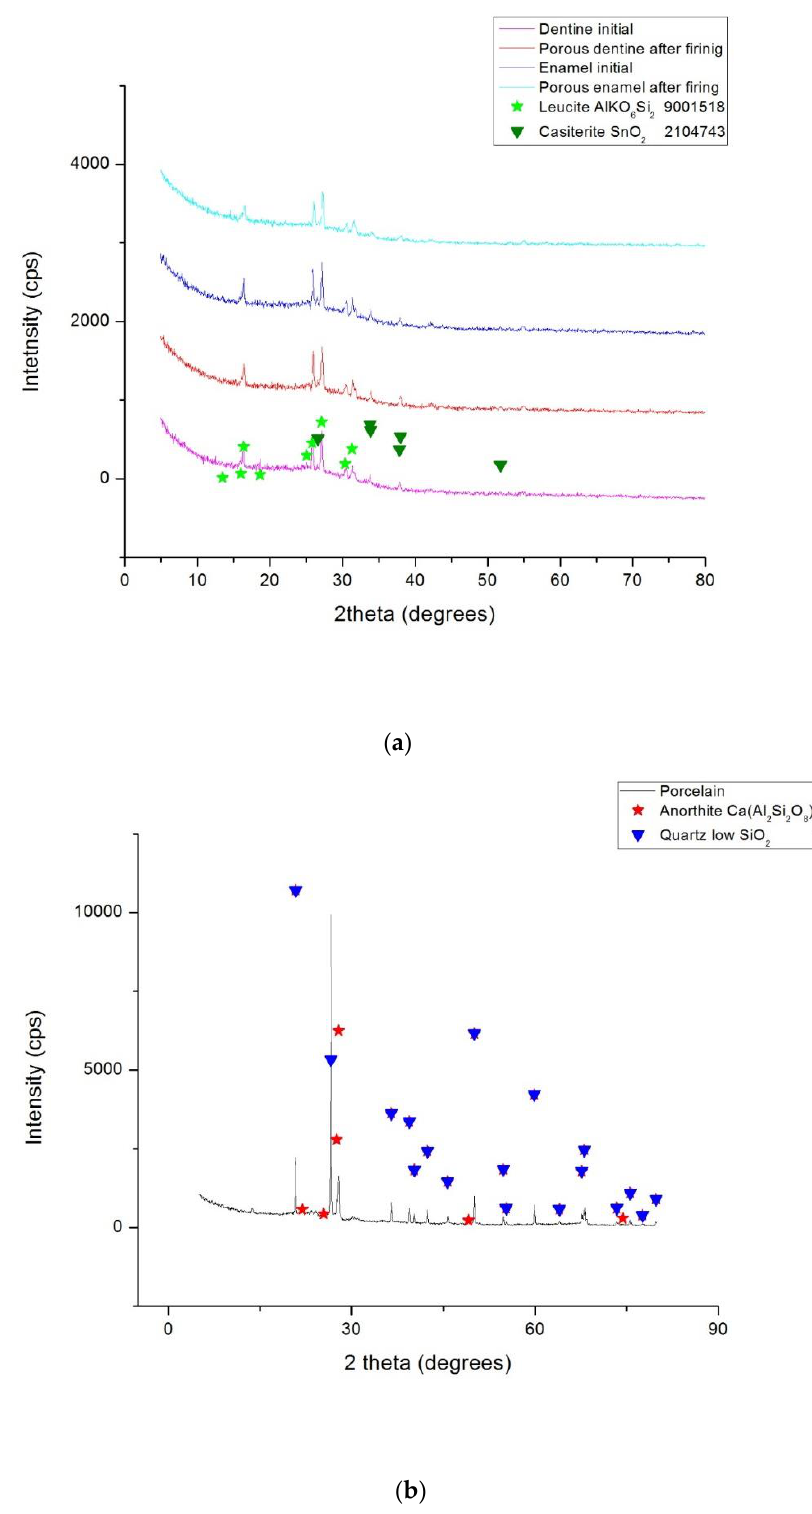
Figure 5. The phase composition of: ( a ) the enamel (E) and the dentin (D) ceramics, corresponding to Groups 1 to 4 (i.e., GE and BE, as well as GD and BD, respectively); ( b ) the new-developed porcelain material — Groups 5 (GC) and 6 (BC).